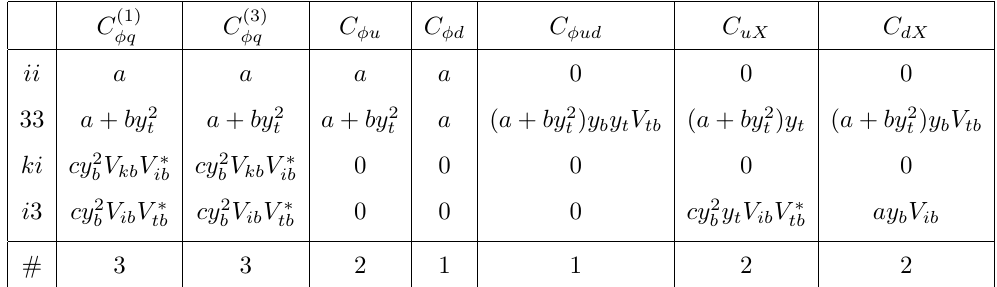
Table 1 . Wilson coefficients of two-quark SMEFT operators in MFV with up-alignment. The flavor indices are i ∈ { 1 , 2 } and k ∈ { 1 , 2 , 3 } with k 6 = i , and X = B, W, G denotes the respective gauge field. Subleading contributions in y and contributions of O ( y ) or smaller have been neglected. b c The last line shows the number of independent degrees of freedom in this expansion of the flavor